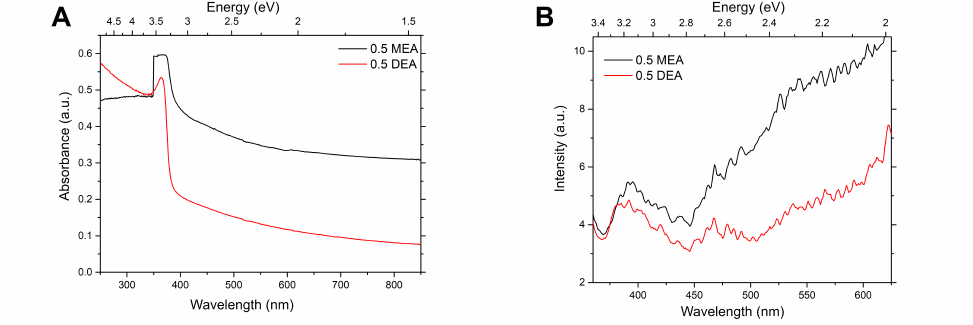
Figure 14. Absorbance ( A ) and photoluminescence ( B ) of samples grown on quartz.